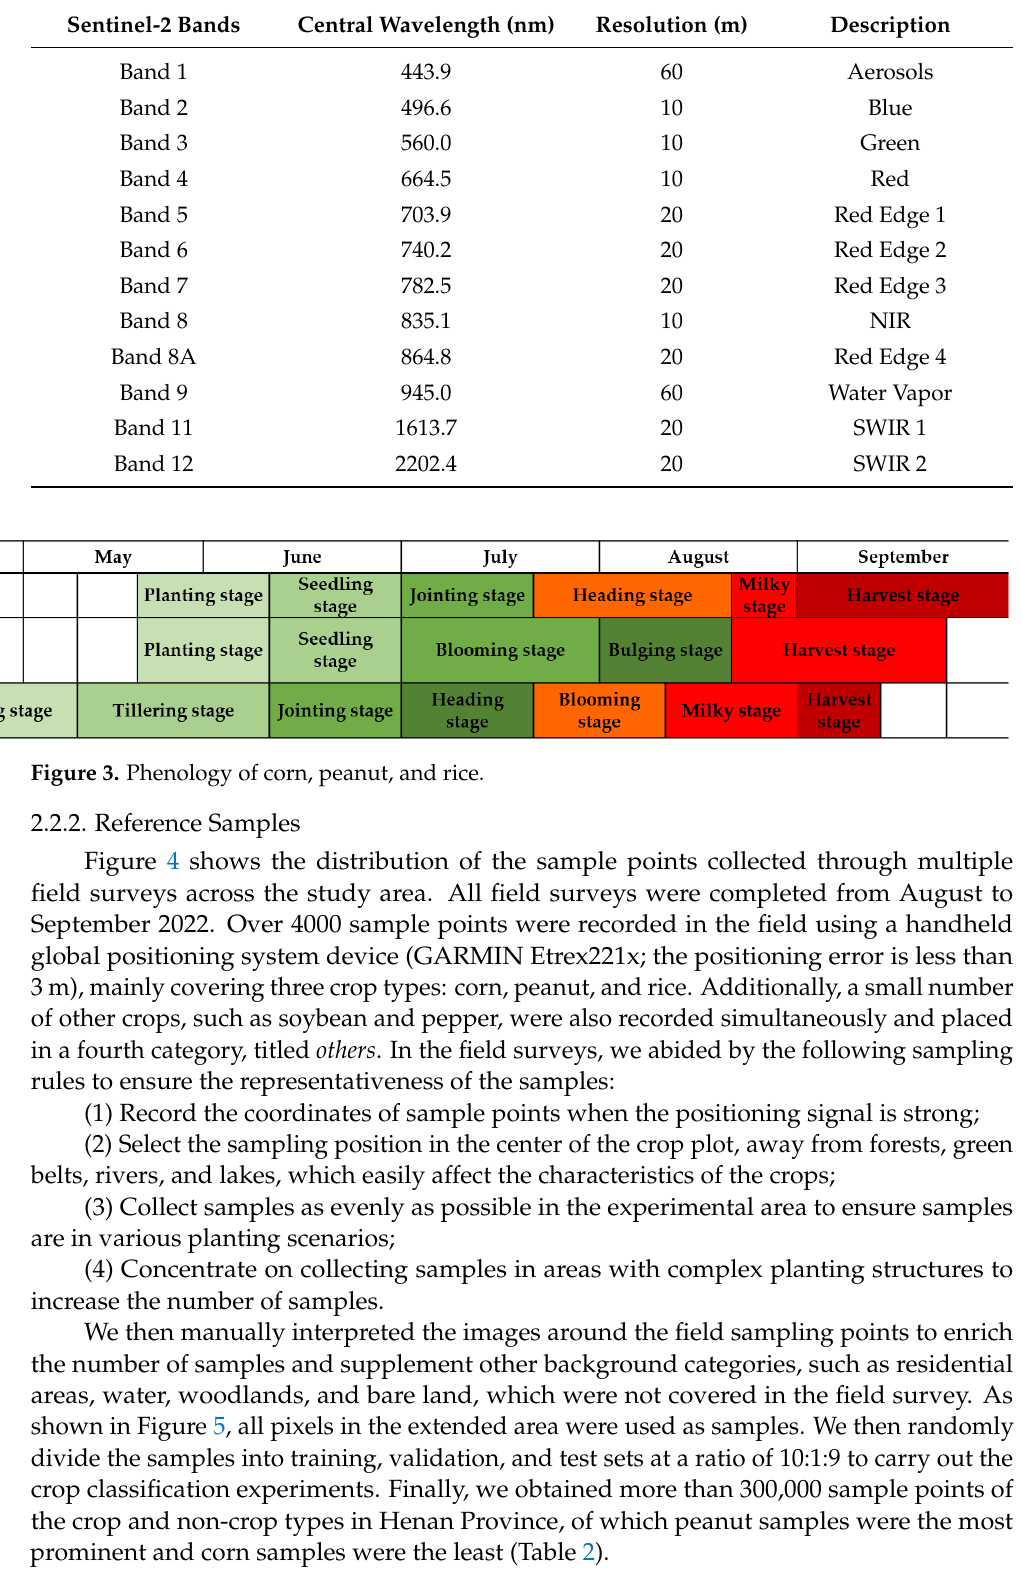
Table 1. Bands Information of Sentinel-2 L2A Images.